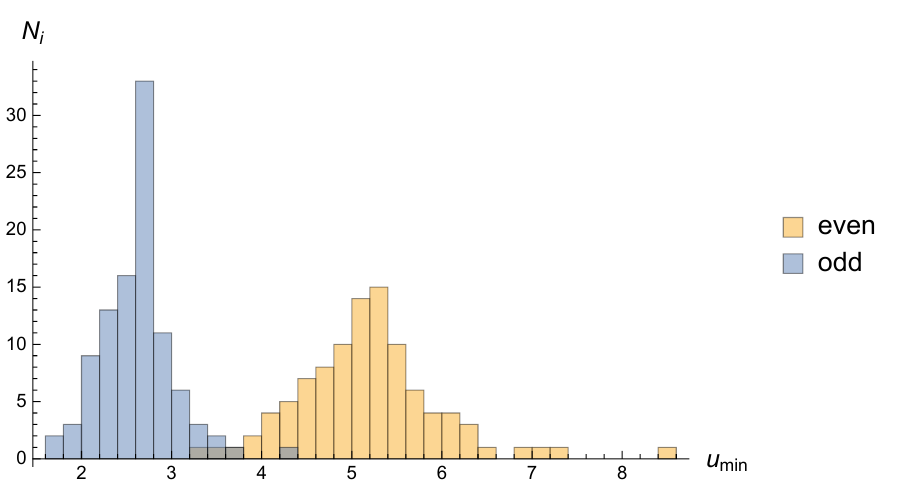
( left ) and u even ( right ), both showing approximate Gaussian min, i min, i